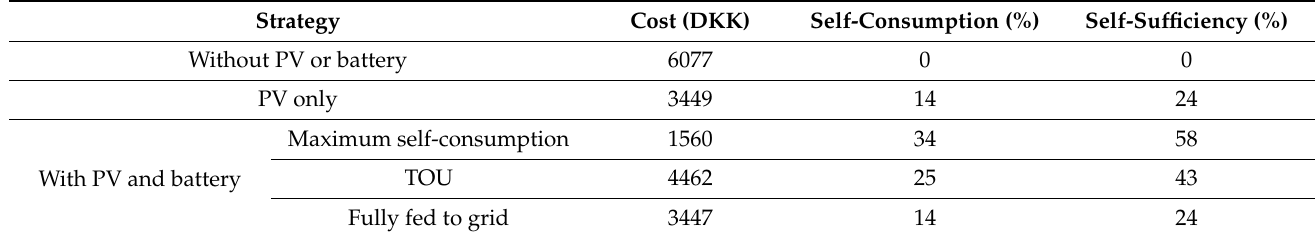
Table 3. Simulation results of different strategies based on spot price in 2020.